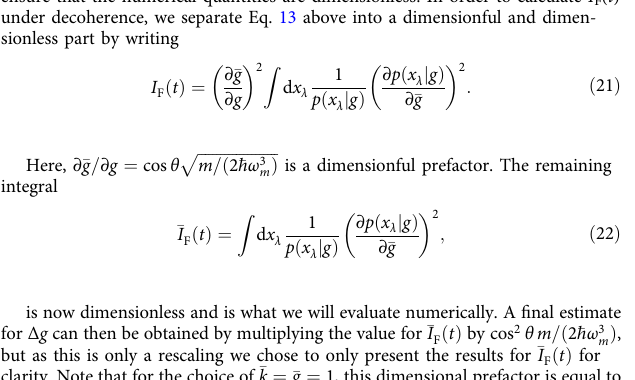
ffiffiffi p ´ 10 (cid:2) 4 in our optomechanical scheme with n respect to atomic interferometers. As n increases, the differences level out. However, different initial states in an optomechanical system, such as the superposition of two Fock states, will also scale with n 2 (see Supplementary Note 5). Strictly speaking, the enhancement is valid for when the cavity fi eld remains